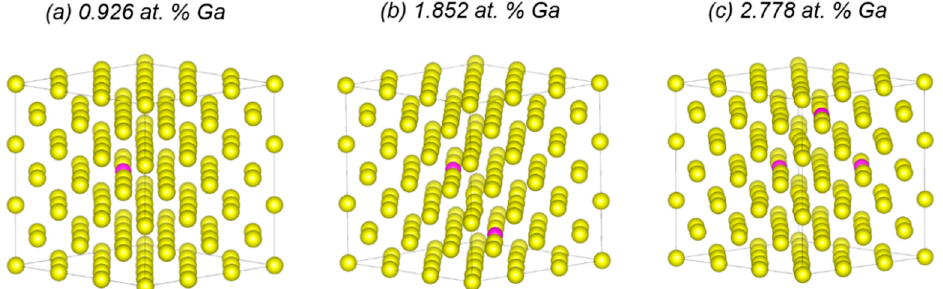
Figure 1. Ga-stabilized δ -Pu structures with ( a ) 0.926, ( b ) 1.852, and ( c ) 2.779 at. % Ga concentrations. The yellow atoms are Pu and purple atoms are Ga. In structures that have multiple Ga atoms, the Ga is placed at fourth nearest neighboring distances from each other.